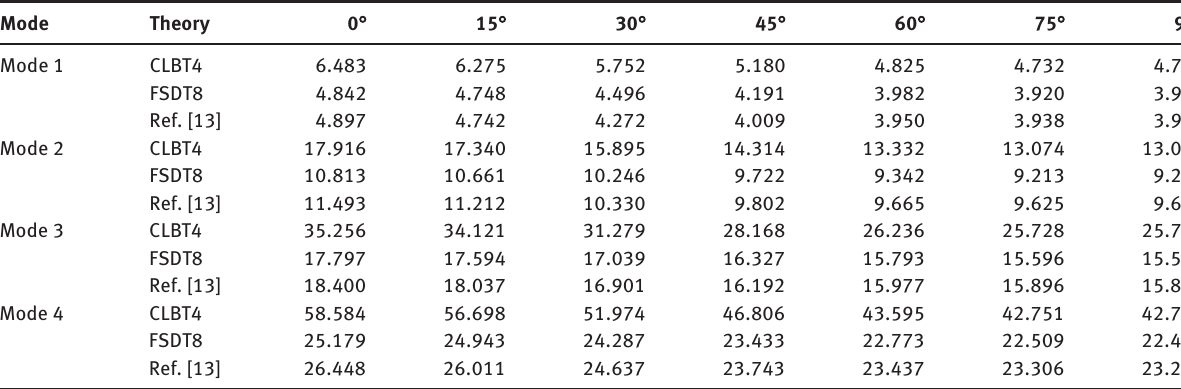
Table 3 The first four non-dimensional natural frequencies of a clamped-clamp unsymmetric angle-ply (0 ° / θ ° ) composite beam with material I.